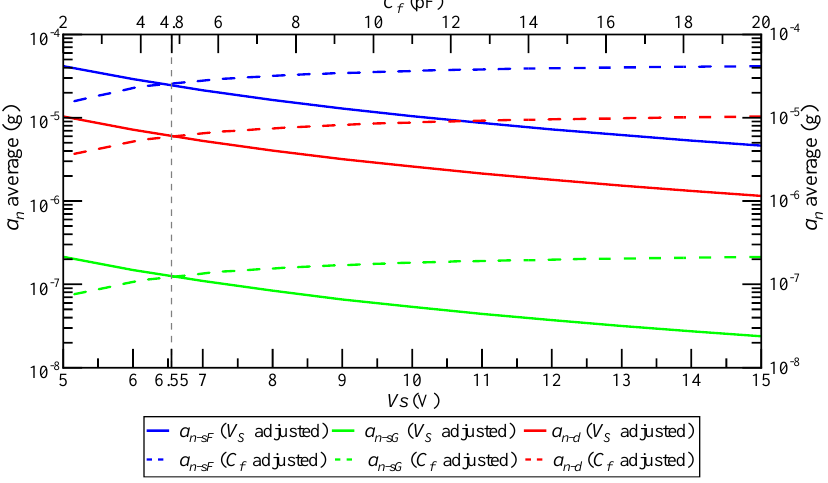
Figure 13. The change rule of the average magnitude of 𝑎 𝑛 when 𝑉 𝑠 and 𝐶 𝑓 are adjusted. When 𝑉 𝑠 is adjusted to the maximum magnitude and 𝐶 𝑓 to the minimum value, the average magnitude of 𝑎 𝑛 is as shown in Table 8. At the same time, when 𝑉 𝑠 is a maximum and 𝐶 𝑓 is a minimum, the suppression effect of the detection noise can be maximized. Table 8. Average value of 𝑎 𝑛 for different values of 𝑉 𝑠 and 𝐶 𝑓 .